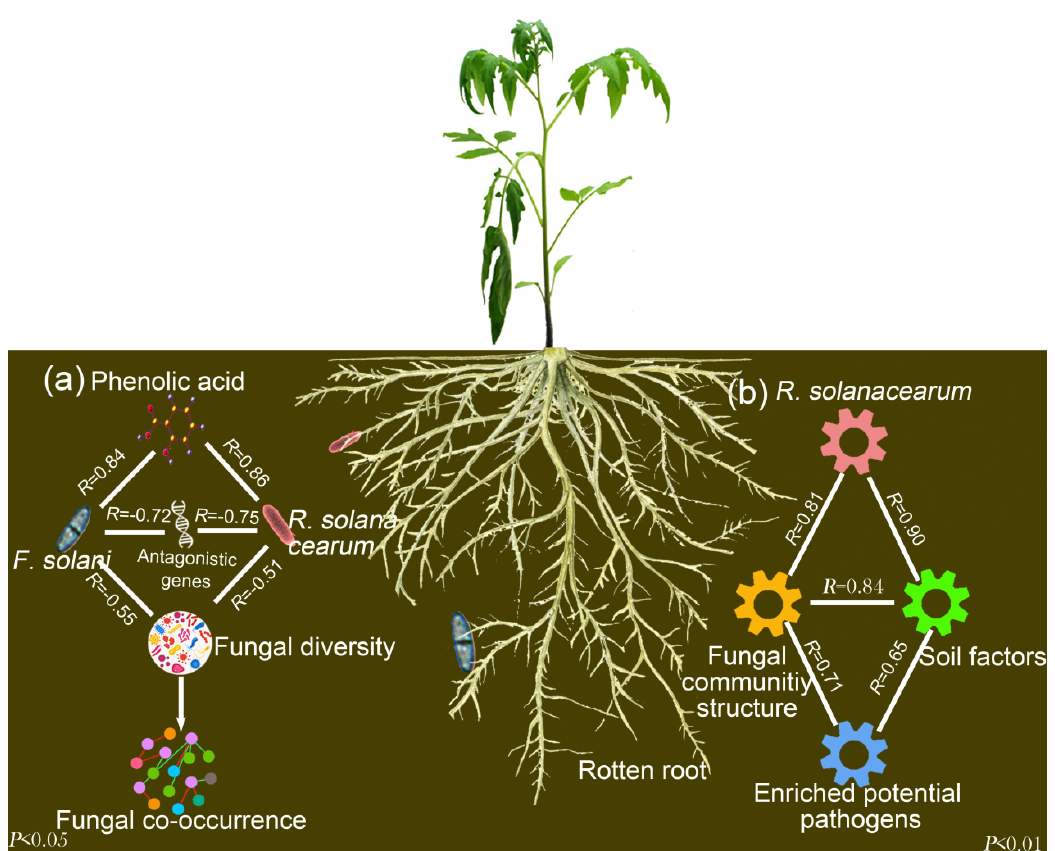
Figure 6. Proposed model for ( a ) R. solanacearum invasion, release of phenolic acids from rotten roots, decrease in antagonistic gene copy numbers, increase in F. solani abundance, decrease in fungal diversity and complexity of fungal co-occurrence; and ( b ) reasons for the changes in fungal community structure.